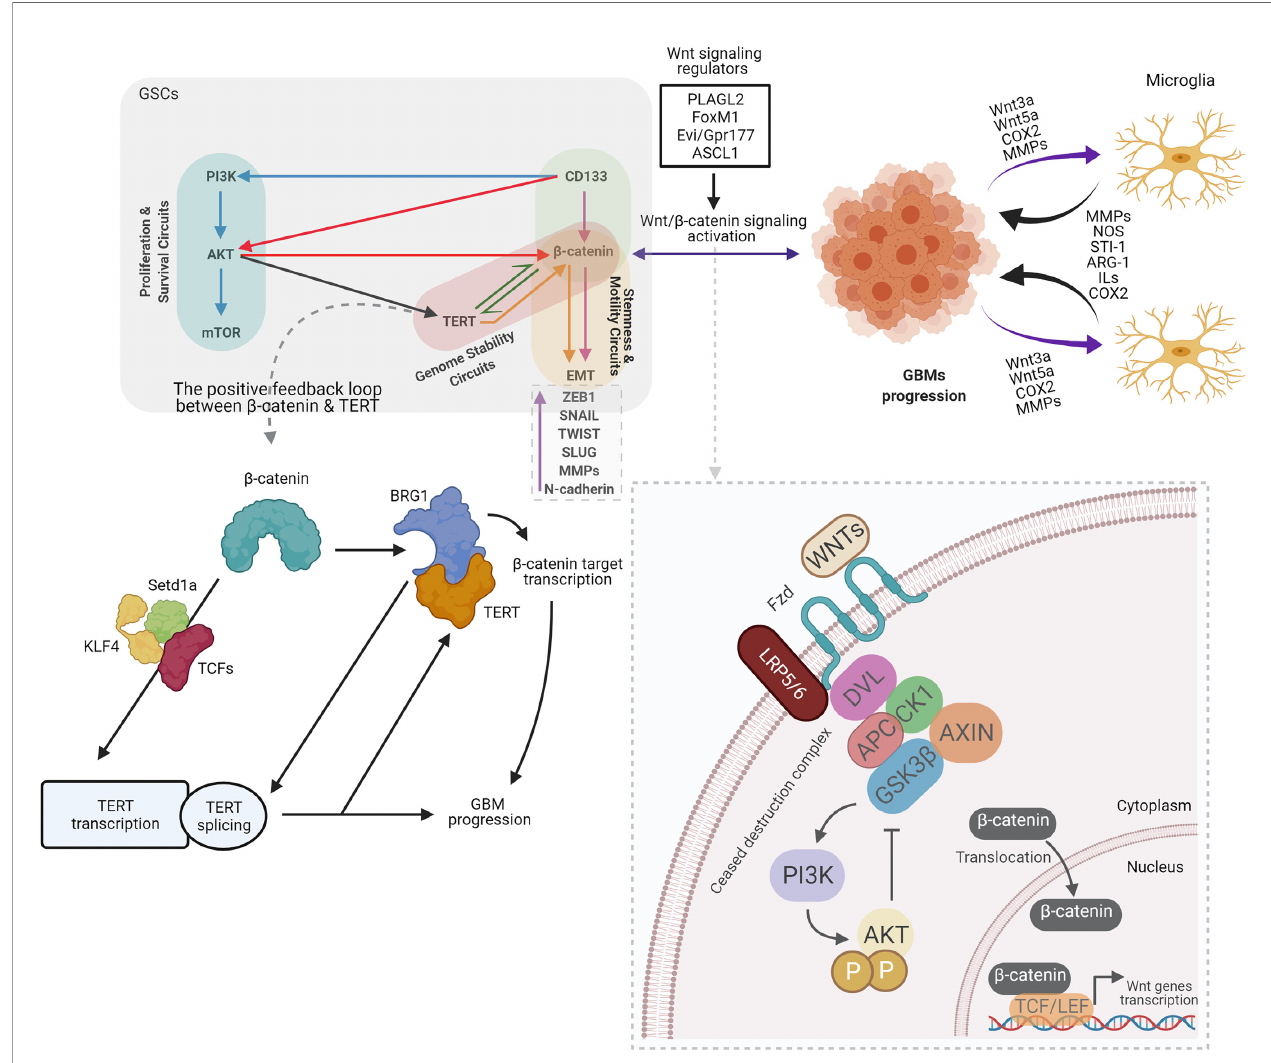
FIGURE 2 | Overview of crosstalk between CD133, Wnt/ b -catenin, and telomerase/TERT in GSCs, old actors and new players. By contributing to tumor growth via secretion of anti-in fl ammatory and pro-tumor factors, particularly in GBMs, Microglia bene fi ts glioma. Several microglia-released molecules, such as STI1, epidermal growth factor (EGF), type 1 membrane matrix metalloproteinase (MT1-MMP), NOS, ARG-1, ILs, and COX2 facilitate the proliferation and migration of GBM. Meanwhile, multiple factors that recruit microglial cells and modulate their polarization are secreted by gliomas, such as Wnt3a, Wnt5a, COX2, and MMPs. GBM cells release Wnt3a in response to Wnt/ b -catenin activation, which could interfere with the low-density lipoprotein receptor-related protein 5/6 (LRP5/6) and the Frizzled receptor. b -catenin stabilized and translocated to the nucleus as a result of this association, and enhanced the transcription of target genes essential for stem and cell migration (35). The Wnt/ b -catenin signaling functions in GBM are de fi ned as follows: GSCs maintenance. Wnt/ b -catenin signaling regulators such as PLAGL2, FoxM1, Evi/Gpr177, and ASCL1 activate Wnt/ b -catenin signaling and increase the stemness of GBM. Invasiveness of GBM cells. Wnt/ b -catenin signaling activation contributes to upregulation of EMT-related genes such as ZEB1, SNAIL, TWIST, SLUG, MMPs, and N-cadherin, leading to increased migration and invasion of GBM cells (36). Several lines of evidence suggest the positive feedback loop between b -catenin and TERT. b -catenin stimulates TERT transcription directly, while TERT serves as a co-factor to facilitate the transcription of the target genes of b -catenin via the recruitment of BRG1, resulting in the creation of a positive feedback loop. Furthermore, BRG1 and P54 (nrb) cooperate to control TERT splicing and facilitate full-length TERT mRNA generation. It has been shown that b -catenin binds directly to the TCF site in the TERT promoter and recruit ’ s lysine methyltransferase Setd1a to the promoter region, while Setd1a catalyzes histone H3K4 trimethylation at the promoter site. TCF1, TCF4, and KLF4 can also be involved in b -catenin mediated TERT transcription. In the light of these fi ndings, along with the in fl uence of TERT on target genes for b -catenin, a positive feedback loop between TERT and b -catenin can be readily present in stem and cancer cells. However, it is not clear if BRG1 participates in the activation of TERT transcription by b -catenin, or whether TERT participates independently (12). PI3K, Phosphoinositide 3- kinases; AKT, Protein kinase B; mTOR, The mechanistic target of rapamycin; TERT, Telomerase Reverse Transcriptase; TWIST, Twist-related protein; COX2, Cyclooxygenase-2; MMPs, Matrix metalloproteinases; NOS, Nitric oxide; STI-1, Stress inducible protein-1; ILS, Interleukins; BRG1, brahma-related gene-1; setd1a, SET Domain Containing 1A; Histone Lysine Methyltransferase; KLF4, Kruppel-like factor 4; PLAGL2, Pleiomorphic adenoma gene-like 2; FoxM1, Forkhead box protein M1; Evi/GPr177, G protein-coupled receptor 177; ASCL1, Achaete-scute homolog 1; DVL, Dishevelled; APC, Adenomatous polyposis coli; CK1, The casein kinase 1; GSK3 b , glycogen synthase kinase 3 b . (Created with